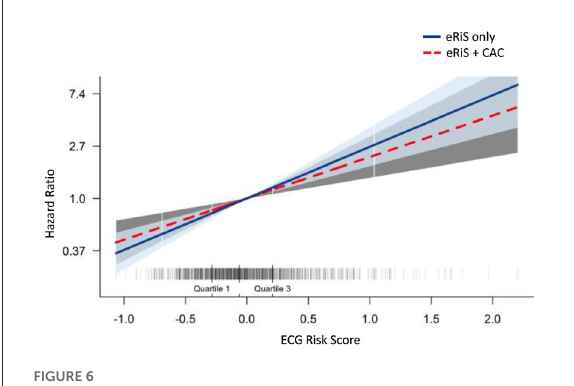
FIGURE6 Additive benefit of eRiS to CAC: Hazard ratio is not attenuated when eRiS is adjusted by CAC score, indicating a strong relationship with MACE which is not weakened by the addition of CAC. Similar results were seen with other splits.